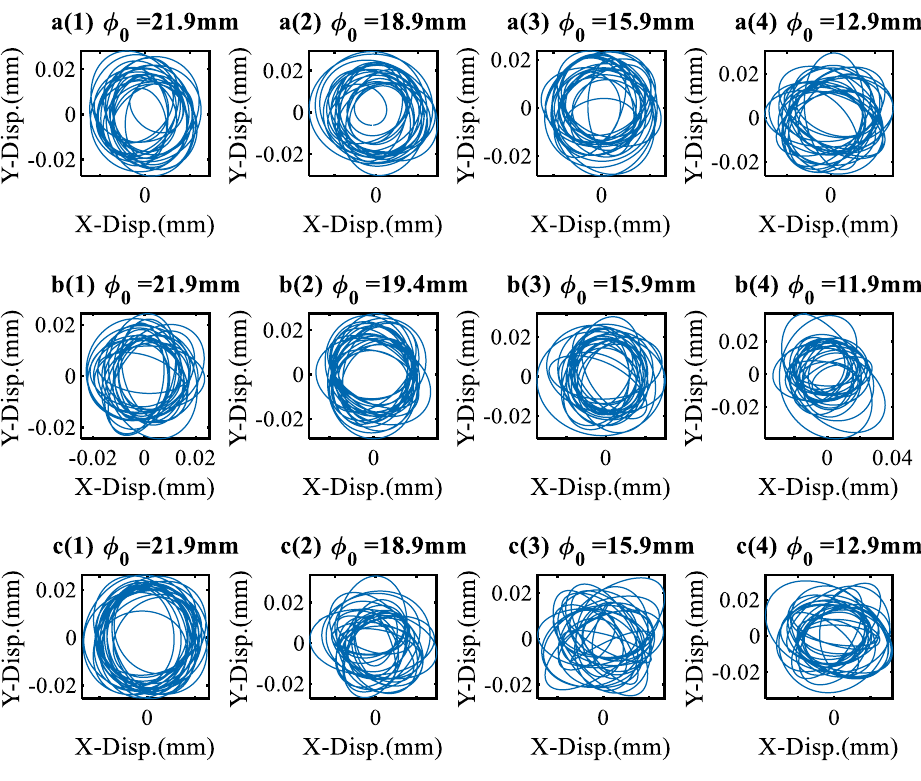
Figure 9. Orbit of the spindle